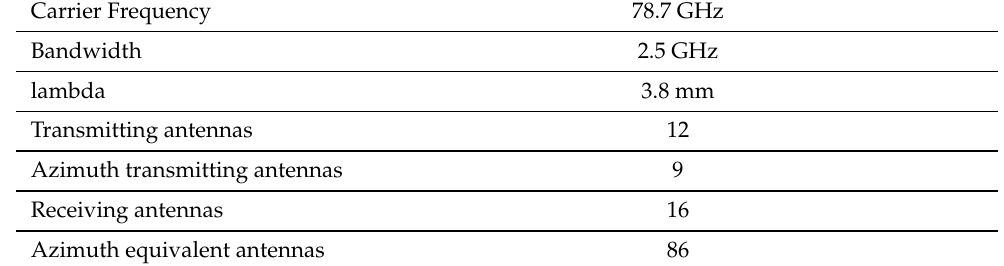
Table 2. AWR2243 cascaded radar parameters.